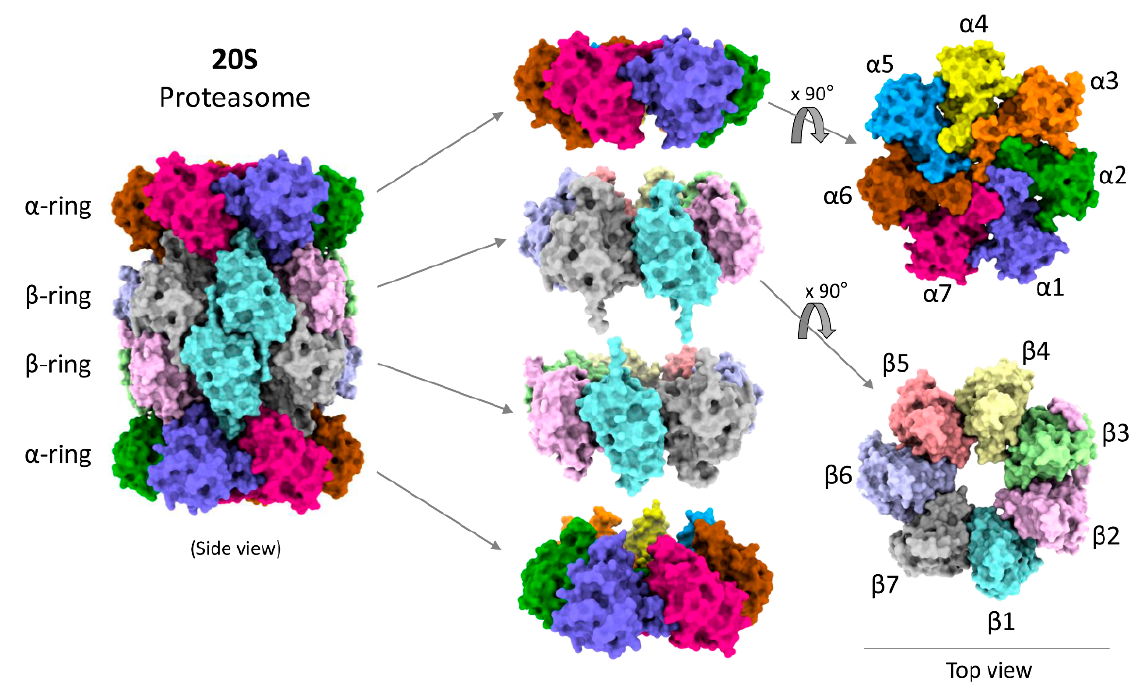
Figure 2. Model structure of human 20S proteasome. Model figures were generated by ChimeraX using the 20S cryo-EM structure [49] .